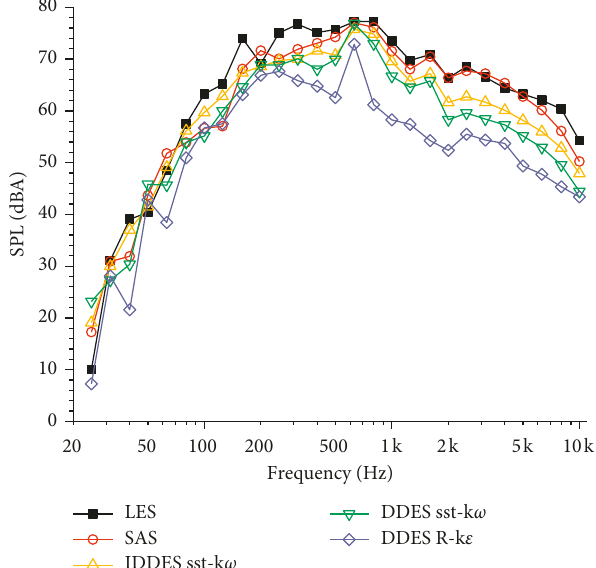
Figure 18: Aeroacoustic frequency spectrum curves of the whole pantograph at the standard observation